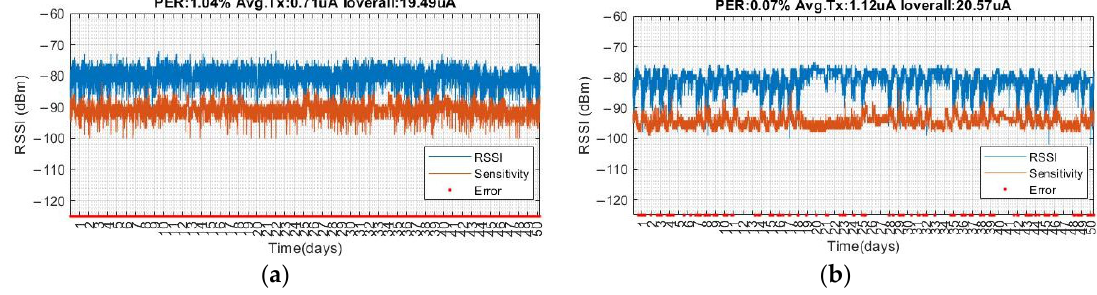
Figure 11. Experimental results for ( a ) Node 1 and ( b ) Node 2.